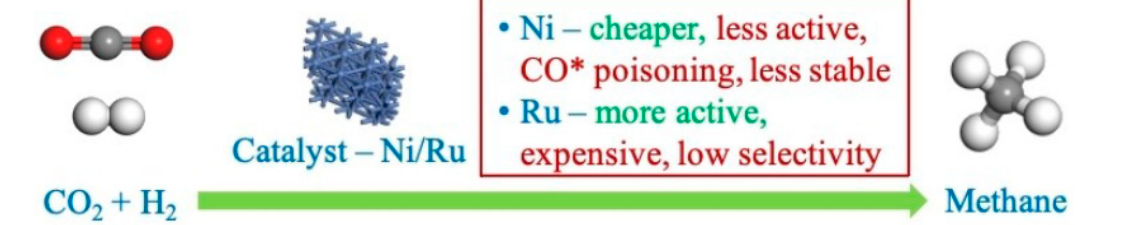
Figure 7. Differential aspects between supported Ni and Ru metals in developing a more active, stable, and selective catalyst for the CO 2 methanation reaction. Adapted from ref. [63]. Copyright 2021 John Wiley and Sons.